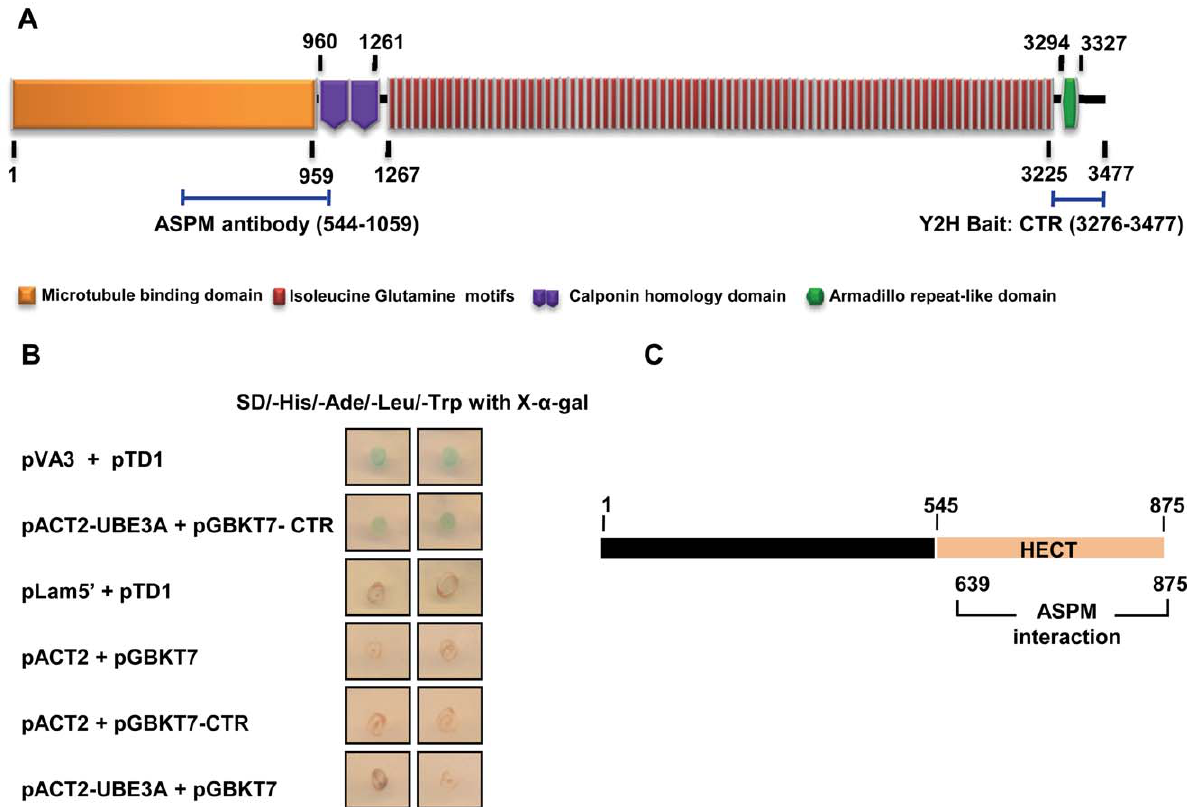
Figure 1. Identification of interaction between ASPM and UBE3A by Y2H analysis. (A) Schematic representation of putative domains and motifs in ASPM. A C–terminal region of ASPM, named CTR (amino acids 3,276–3,477) used as a bait in Y2H analysis is shown. An N-terminal region (amino acids 544–1,059) encompassing the predicted microtubule binding domain and a part of calponin homology domain used for antibody generation is also shown. (B) Y2H screening of transformants by nutritional selection and X- a -gal plate assay. Note growth and blue color for transformants harboring pVA3 + pTD1 (positive control) and pACT2-UBE3A + pGBKT7-CTR. As expected, no growth and blue color were observed for transformants harboring pLam5 9 + pTD1, pACT2 + pGBKT7, pACT2 + pGBKT7-CTR and pACT2-UBE3A + pGBKT7. (C) Schematic representation of UBE3A protein. The ASPM interacting region of UBE3A (amino acids 639–875) is located within the HECT domain (amino acids 545 to 875). The numbers represent amino acid